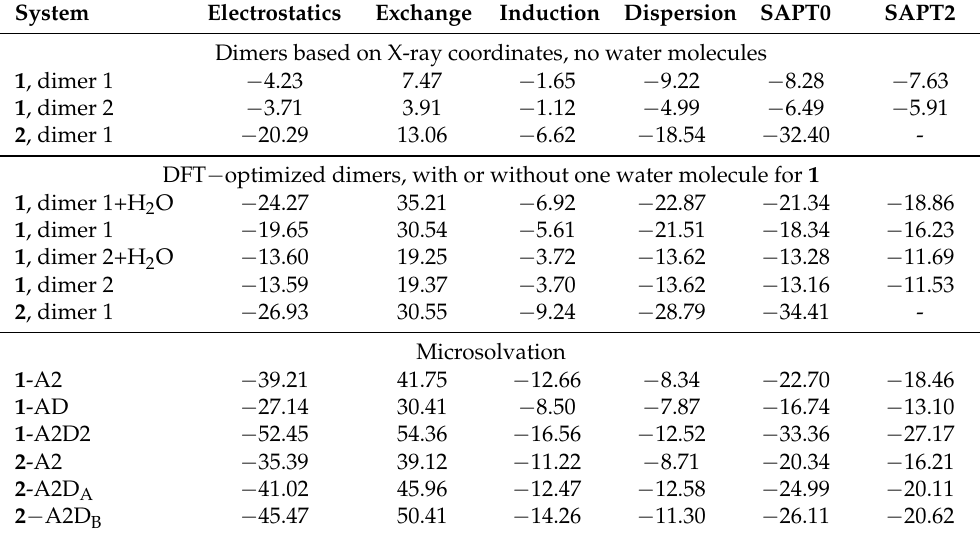
Table 1. SAPT interaction energy partitioning at the SAPT2/jun-cc-pVDZ level of theory. All terms in kcal/mol. System